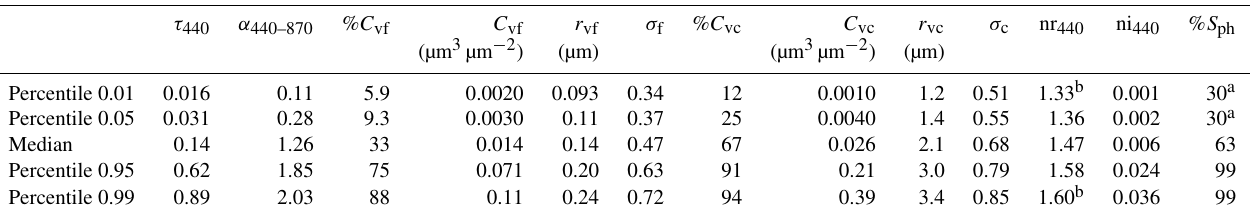
Figure 1. Location of the 851 AERONET sites with their number of retrievals. Table 1. Description of the database of aerosol microphysical properties for aerosol optical thickness τ at 440nm and the Ångström coeffi- cient α (440, 870).